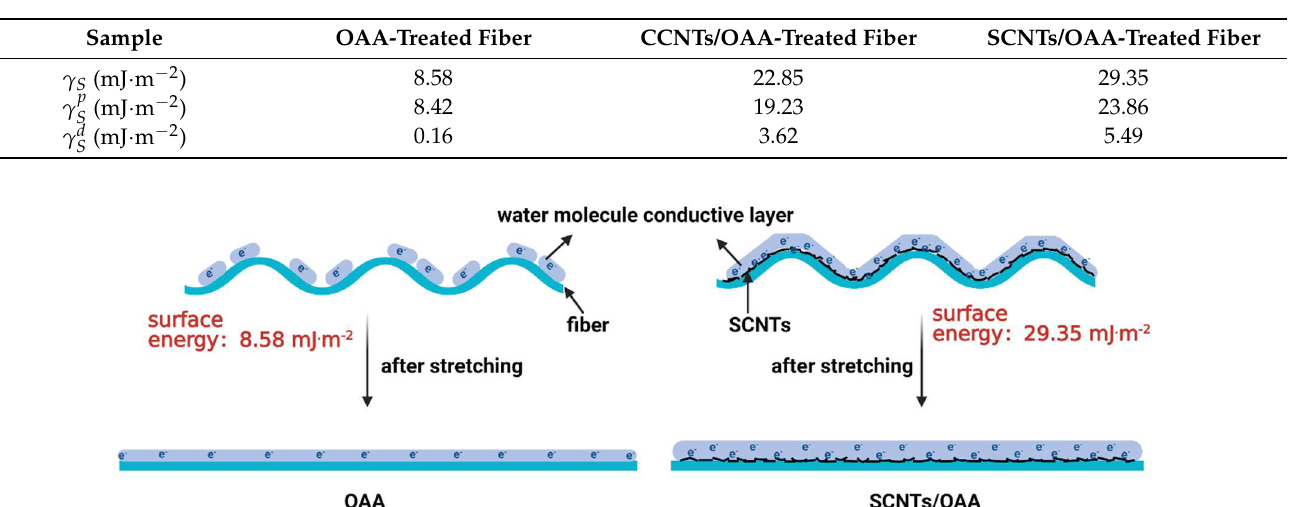
Figure 7. ( a ) Resistivity of fiber with different elongation; the contact angle of ( b , b ’) OAA-treated fiber, ( c , c ’) CCNTs/OAA-treated fiber, and ( d , d ’) SCNTs/OAA-treated fiber with water ( b , c , d ) and ethylene glycol ( b ’, c ’, d ’), respectively. Table 2. The surface energy of fibers. Table 2. The surface energy of fibers.